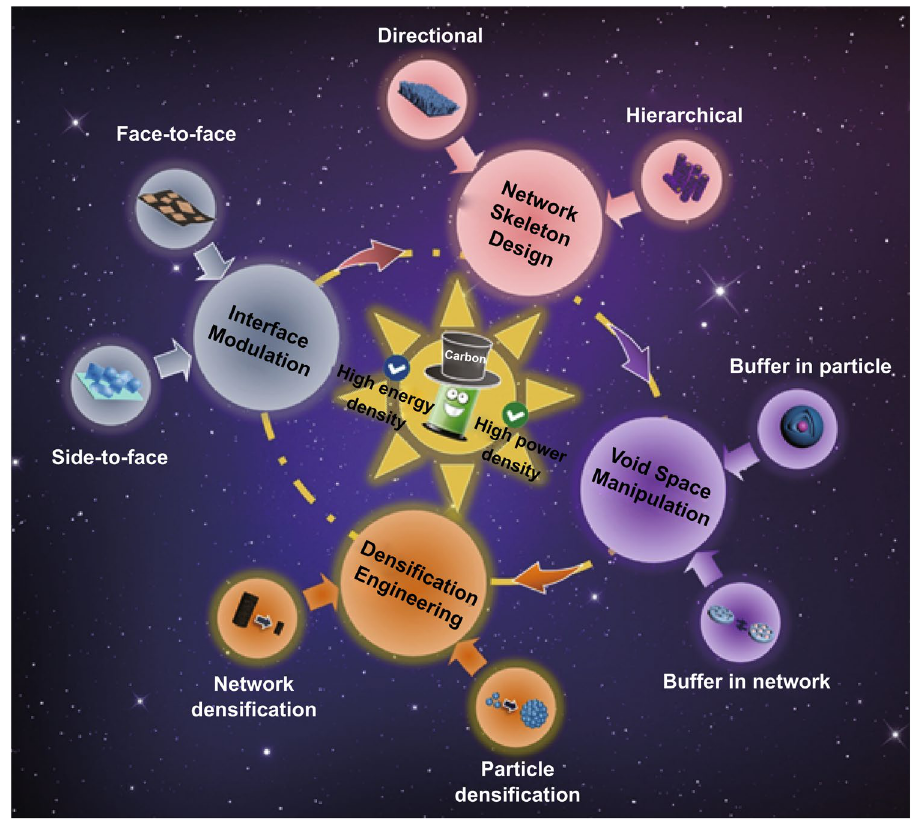
Fig. 1 Carbon‑architecture assembly strategies for building high‑energy and high‑power